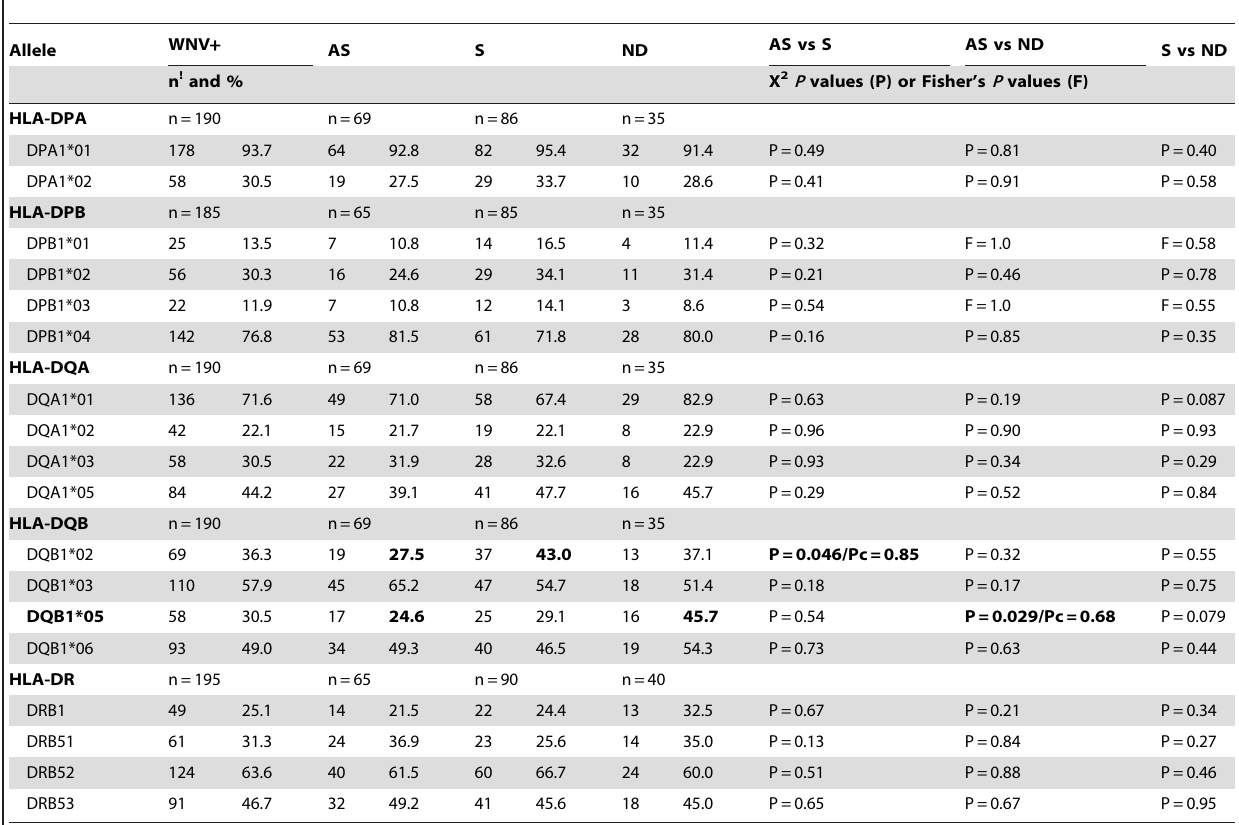
Table 3. Pair-wise analysis of HLA Class II phenotype frequencies* in asymptomatic (AS), symptomatic (S), and neuroinvasive disease (ND) groups of WNV + subjects.